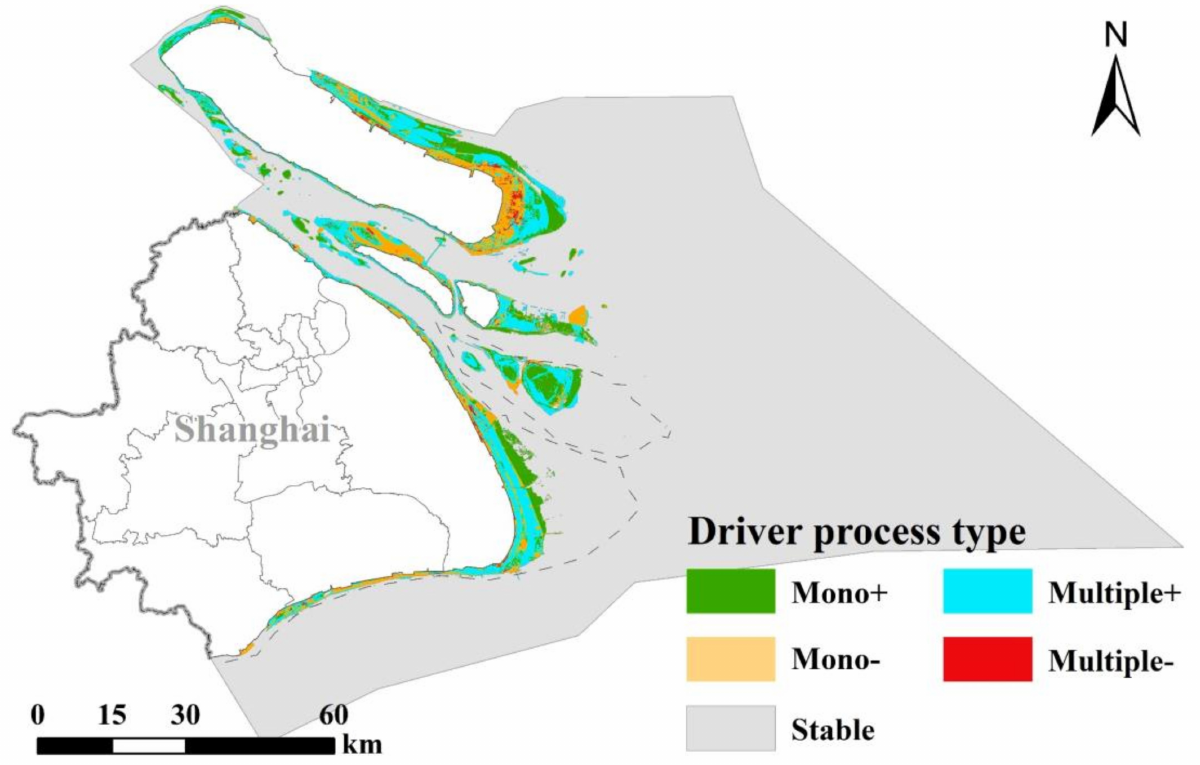
Figure 6. The spatial distribution of the four driving processes during 1990–2015. Note: Mono+: increase in carbon storage by a single driving process; Mono − : decrease in carbon storage by a single driving process; Multiple+: increase in carbon storage by multiple driving process: Multiple − : decrease in carbon storage by multiple driving process; Stable: no change in carbon storage and land cover. For example, A-E-A indicates accumulation of multiple influences (‘Accretion–Erosion– Accretion’) on carbon storage across the 25